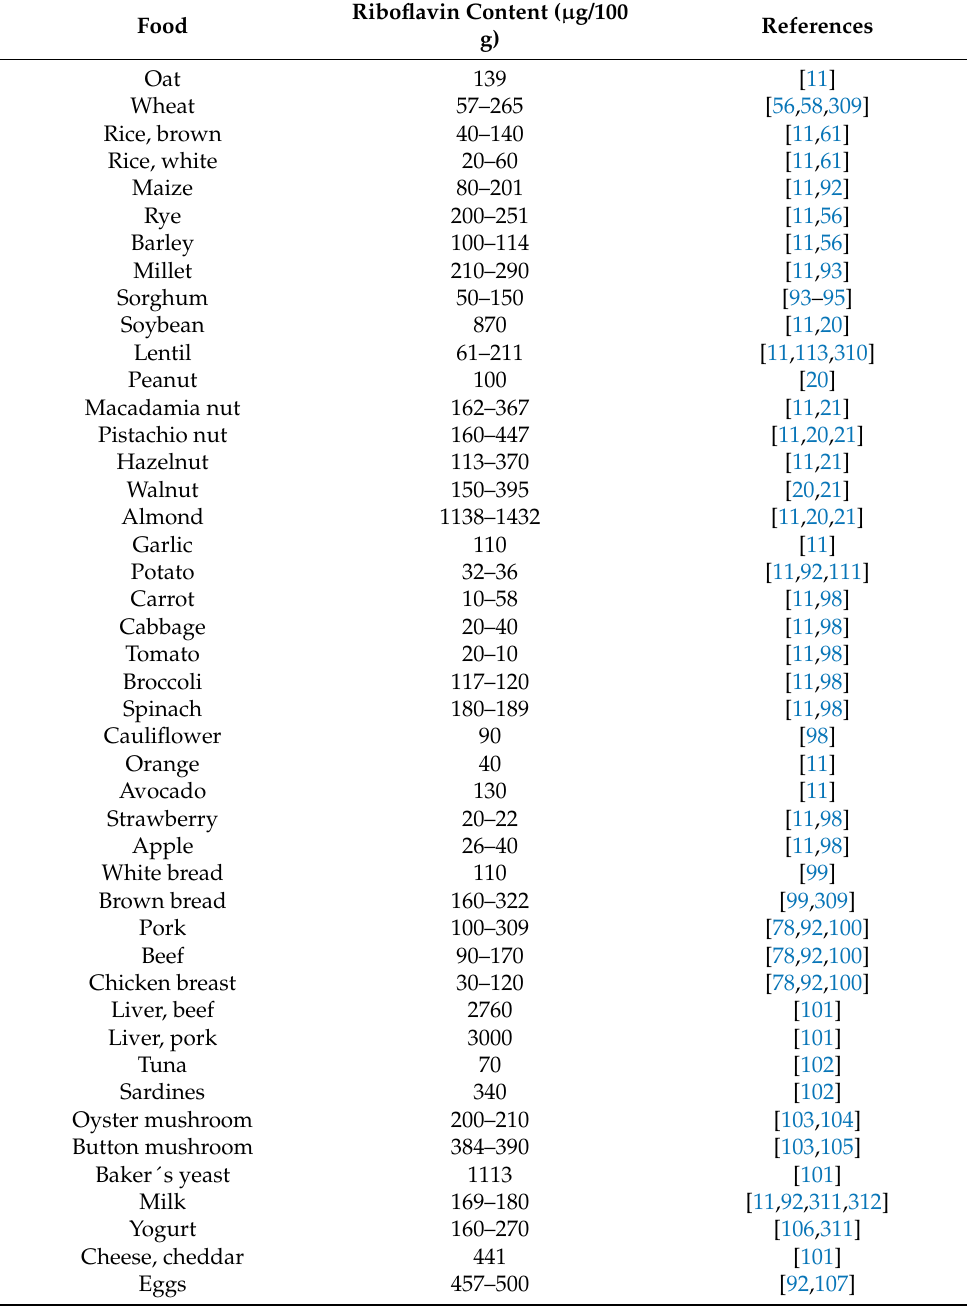
Table 5. Riboflavin contents in selected